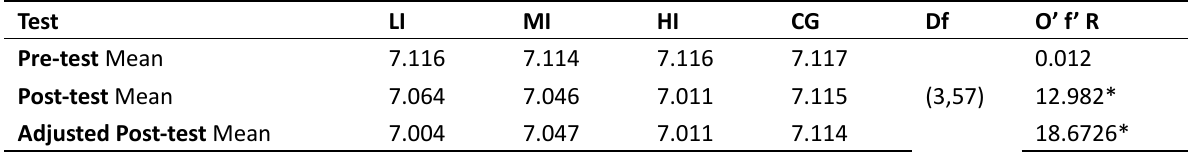
Table 2. Showing the analysis of covariance of pre-test, post-test, and Adjusted post-test on the speed of experimental and control groups